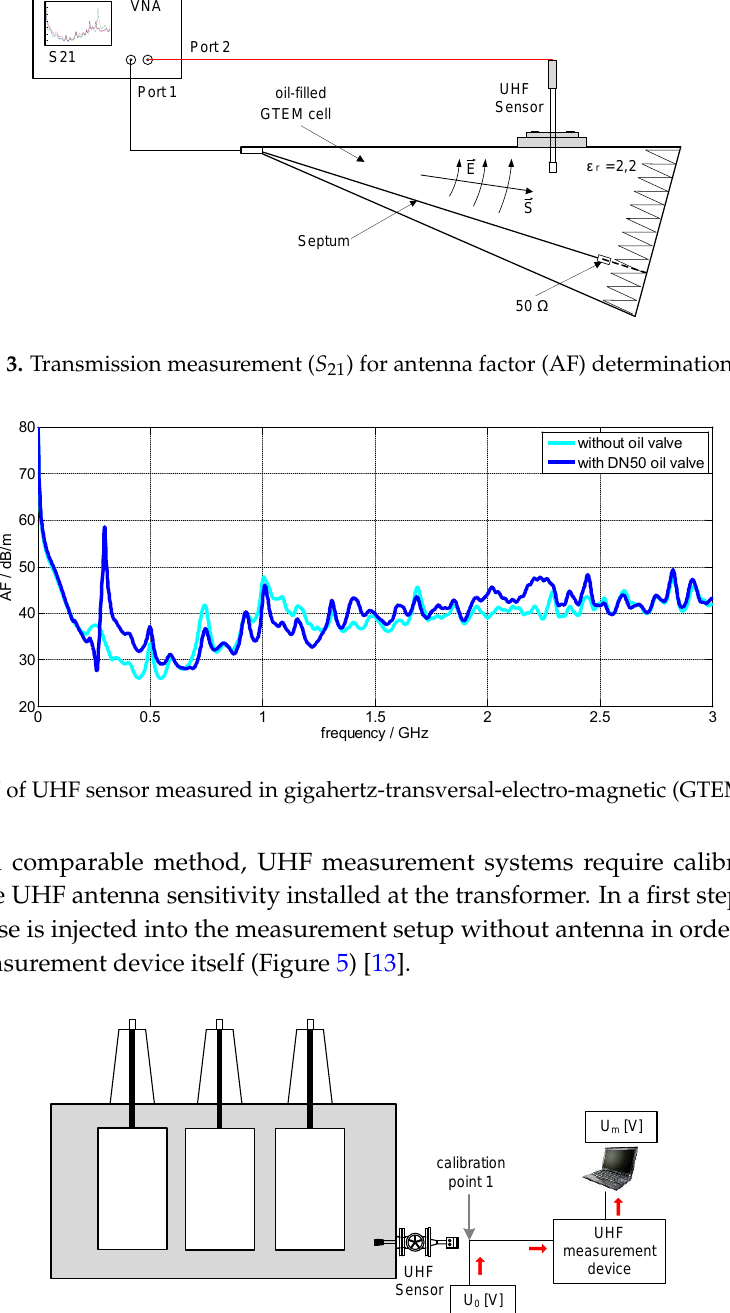
Figure 5. Calibration of measurement device and cables [13].